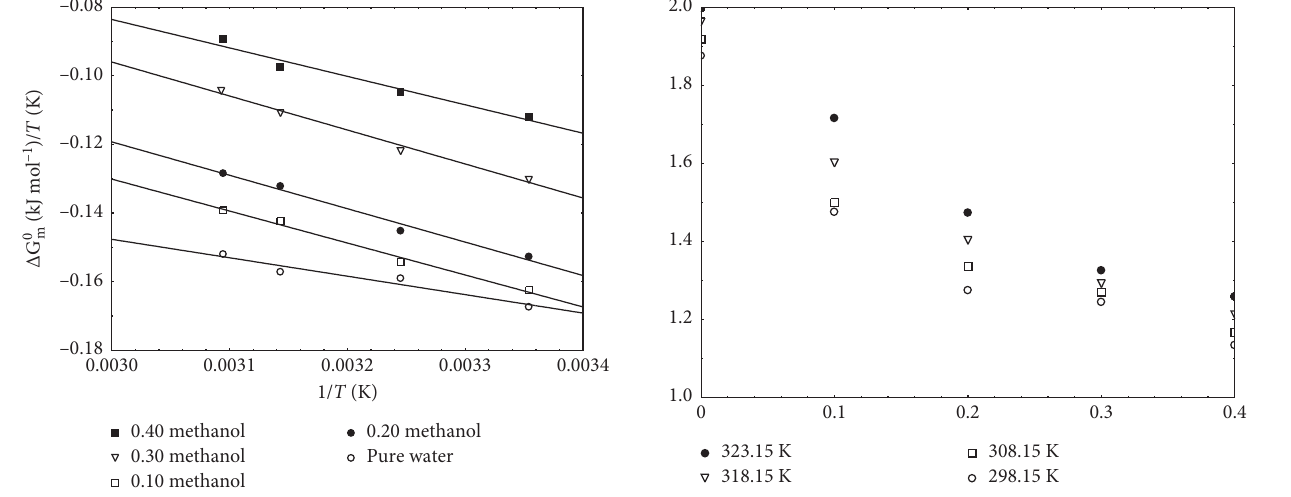
Figure 2: Plot of Δ G o / T with 1/ T of CTAB solution in pure water m and different volume fractions of methanol-water.